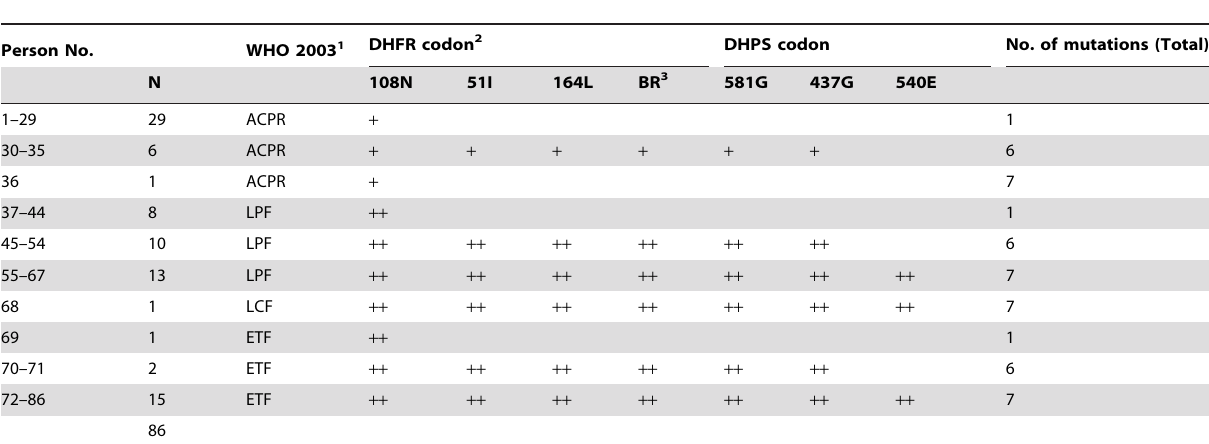
Table 1. Occurrence of mutations 1 and treatment outcome [25].